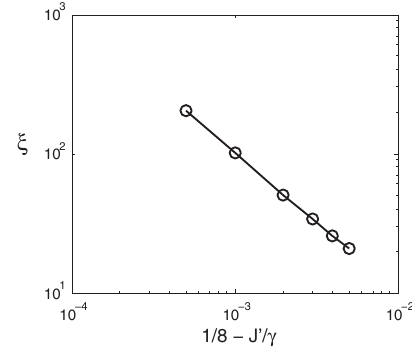
σ x . At the phase transition, ξ m n i